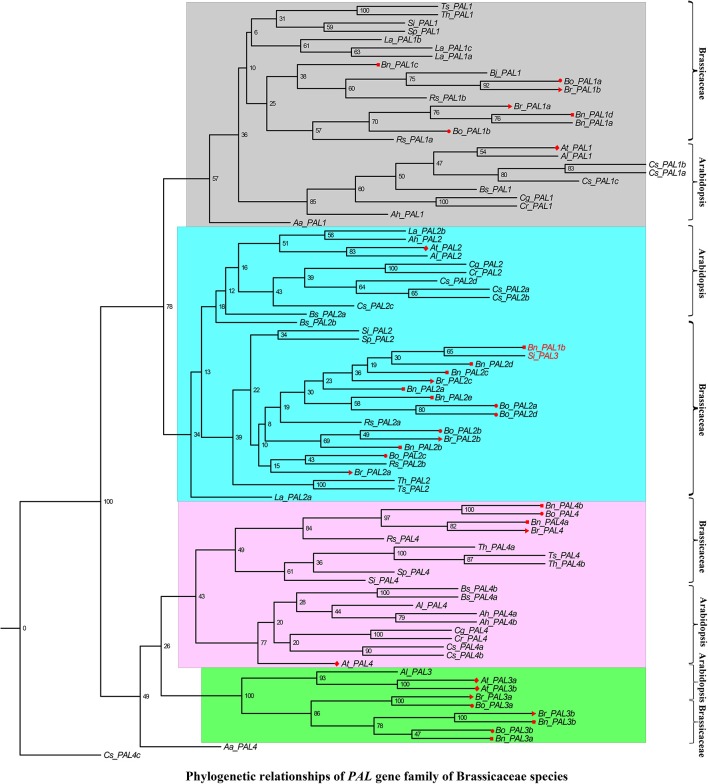
Phylogenetic relationships of PAL gene family of Brassicaceae species. PAL1, PAL2, PAL3, and PAL4 were indicated by gray, light blue, purple and green color. The Bn_PAL1b and Si_PAL3 were denoted by red font that maybe the synonymous of PAL2. The Red color diamond, triangle, circle, and rectangle were denoted the gene copies in A. thaliana, B. rapa, B. oleracea, and B. napus, respectively. Scale bar (the numbers) indicates the estimated number of amino acid substitutions per site.